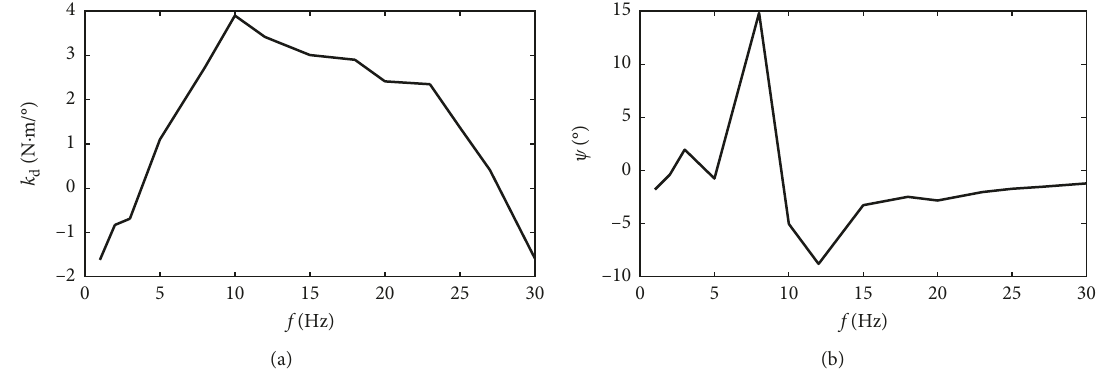
Figure 17: Model error curve with excitation amplitude of θ